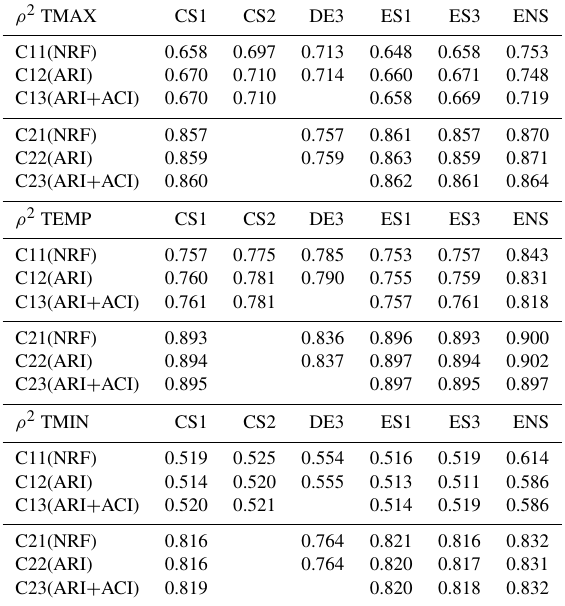
Table 4. Domain-averaged coefficient of determination ( ρ 2 ) for the fire (C1X) and dust (C2X) episodes of each simulation with respect to the E-OBS database.